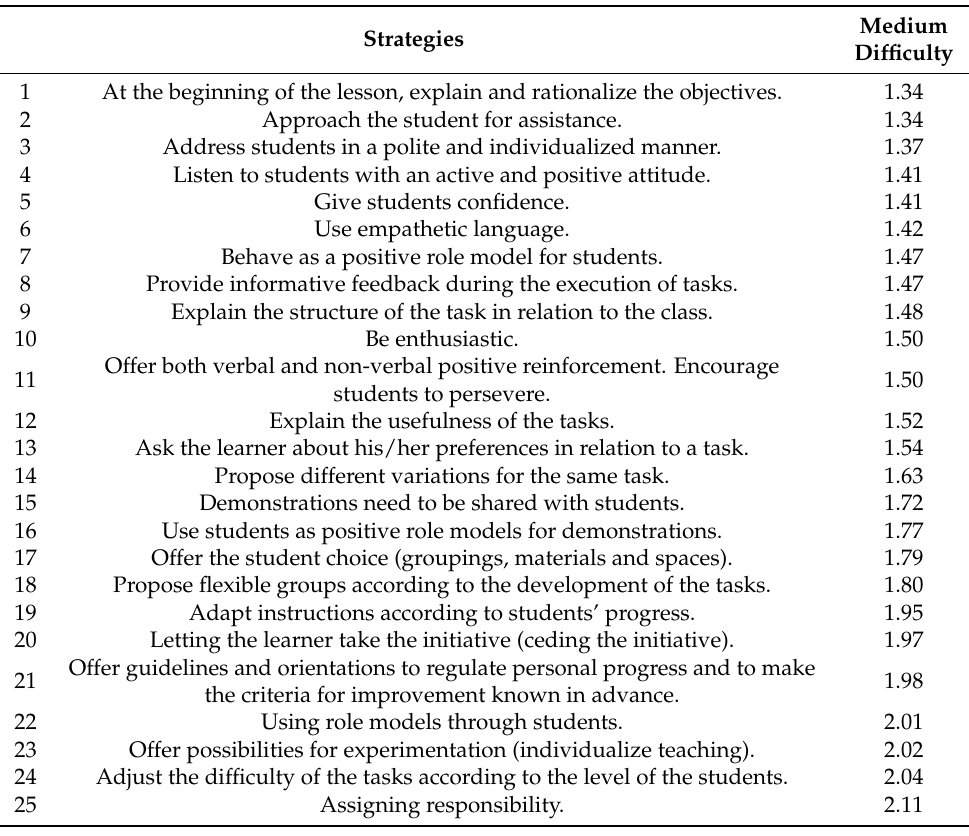
Table A2. Difficulty rating of autonomy support strategies.